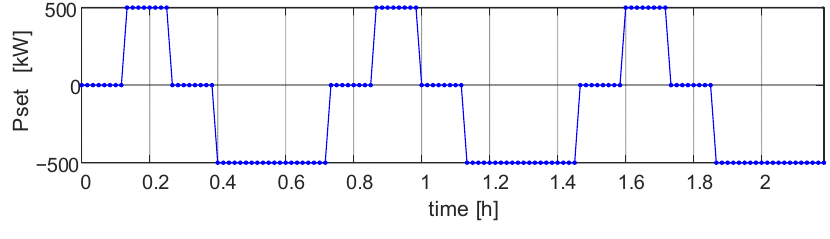
Figure 11. Set operation plan of the BESS.